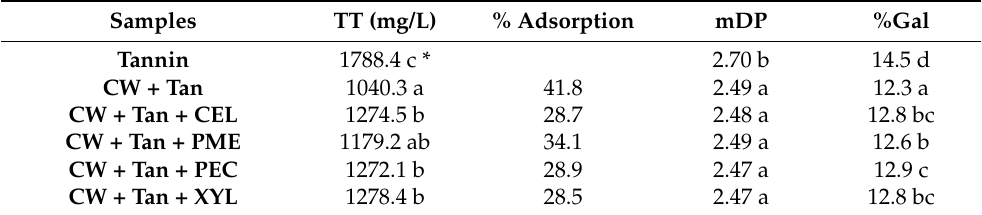
Table 1. Concentration and composition of tannins that remained in solution in the adsorption test. Samples TT (mg/L) % Adsorption mDP %Gal Tannin 1788.4 c * 2.70